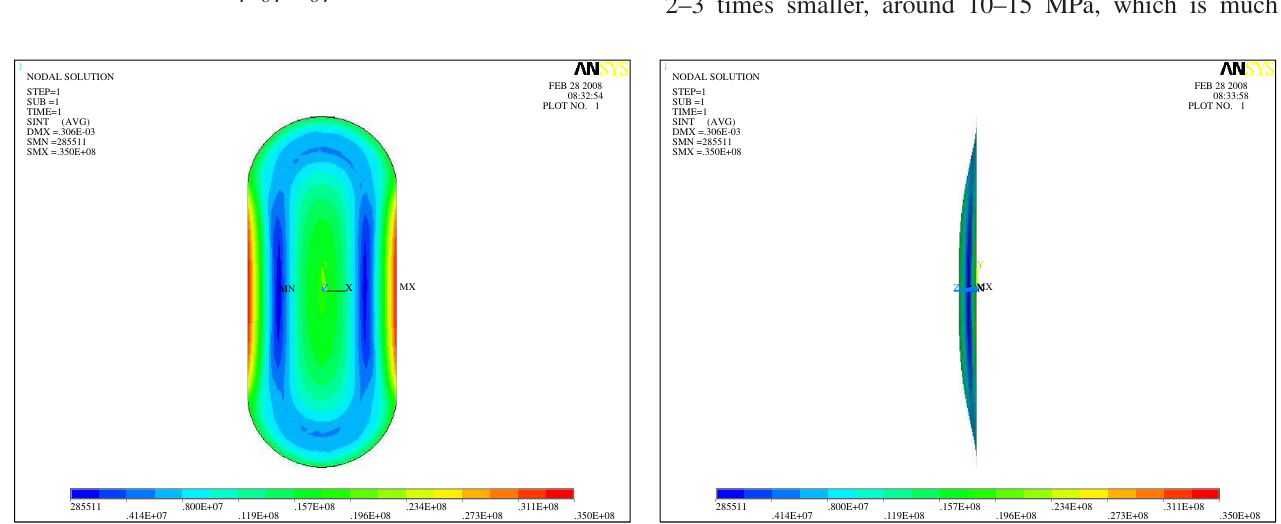
FIG. 22. (Color) Displacement and distribution of the mechanical stress intensity over the CLIC exit window.